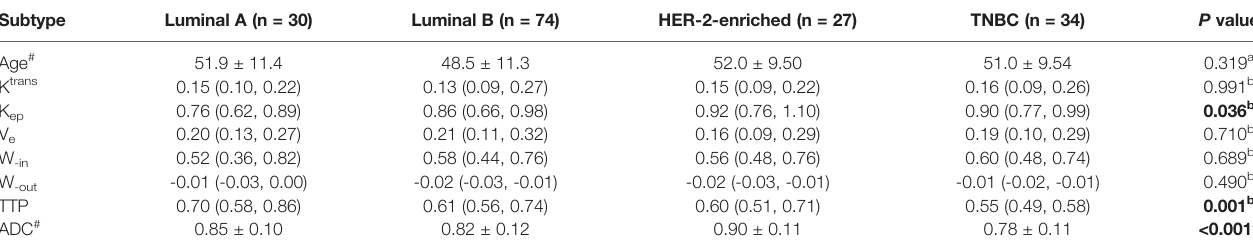
# Indicates the results are the mean value with standard deviation. All other results are the median with interquartile range in parentheses. P a : one-way ANOVA test. P b : Kruskal – Wallis H test. TNBC, Triple-negative breast cancer; ADC, Apparent diffusion coef fi cient. Bold values indicate statistically signi fi cant in P